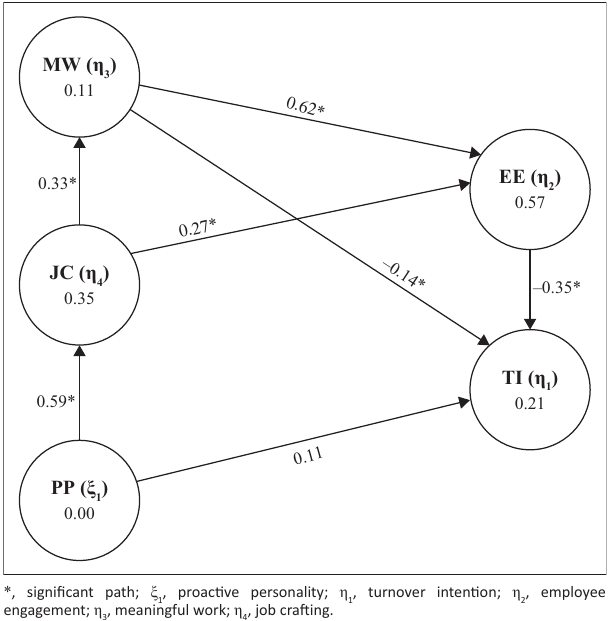
FIGURE 3: Partial least squares report for the revised employee engagement and turnover intention structural model.